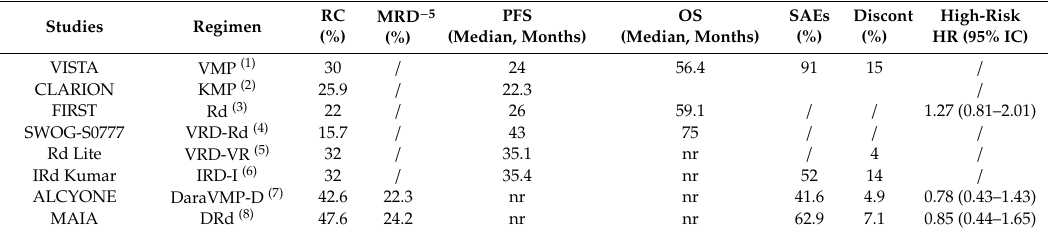
Table 1. Results of trials upfront in non transplant eligible newly diagnosed multiple myeloma (NTE